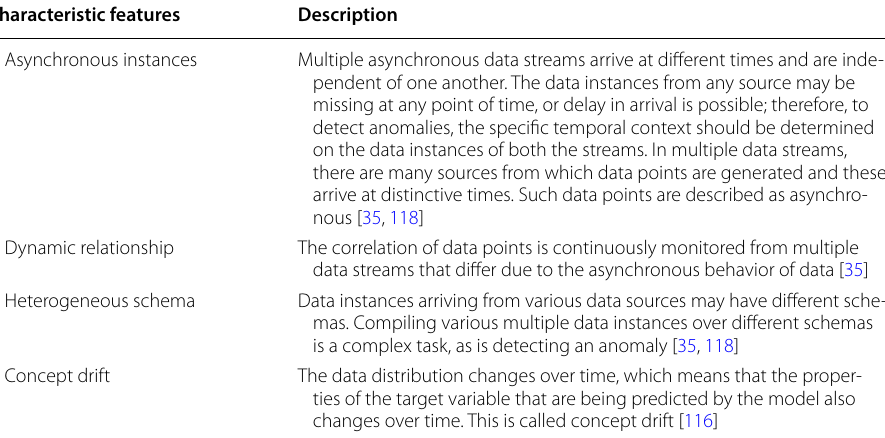
Table 5 Challenges of anomaly detection in context of big data problem (velocity aspect) Characteristic